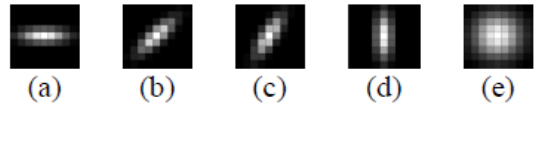
Figure 6. Example of 9 × 9 DGF kernels with